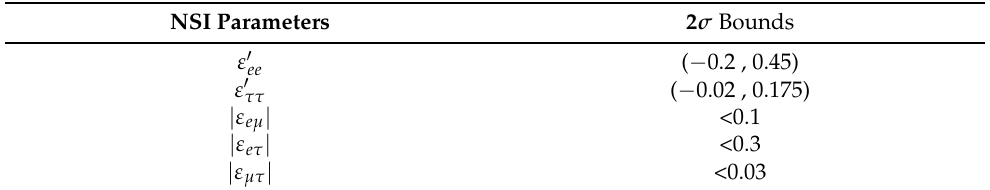
Table 2. 2 σ bounds on the moduli of the NSI parameters, from